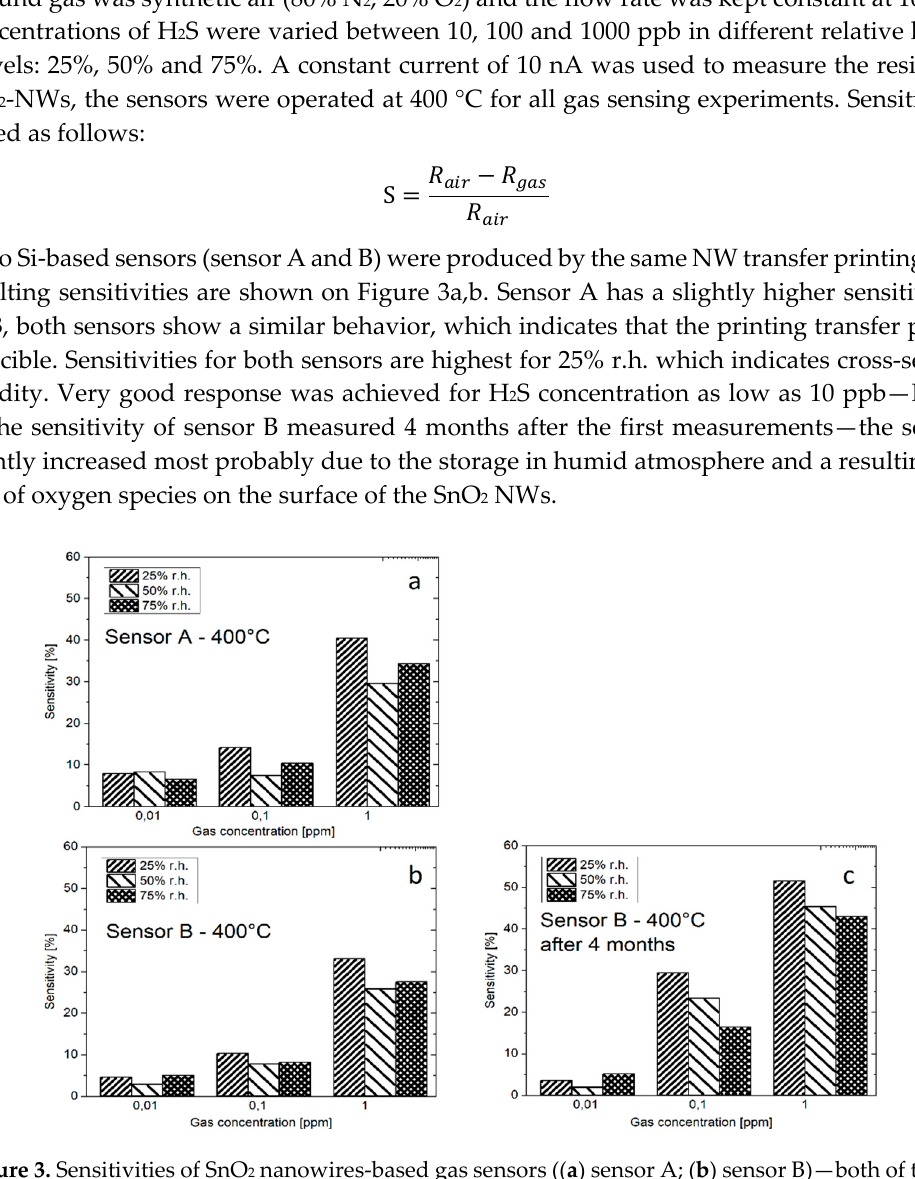
Figure 3. Sensitivities of SnO 2 nanowires-based gas sensors (( a ) sensor A; ( b ) sensor B)—both of them prepared by the same technology. The sensitivity of sensor B increases after 4 months of storage ( c